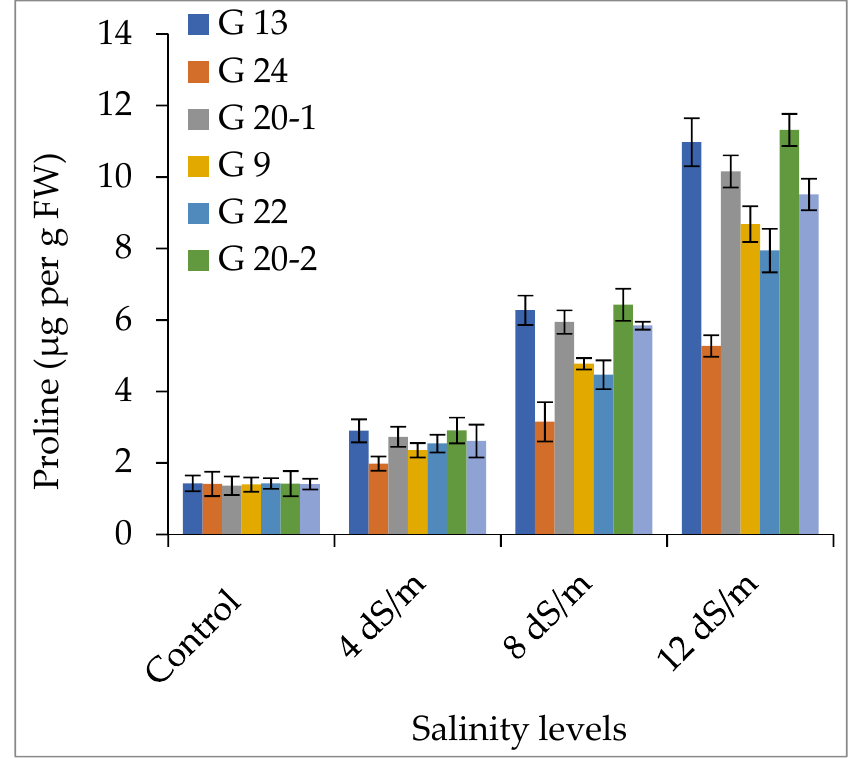
Figure 9. Proline content in leaf of wheat genotypes under various salinity levels. The vertical bar indicates average data of five independent replicates ( n = 5). Error bars represent standard error.